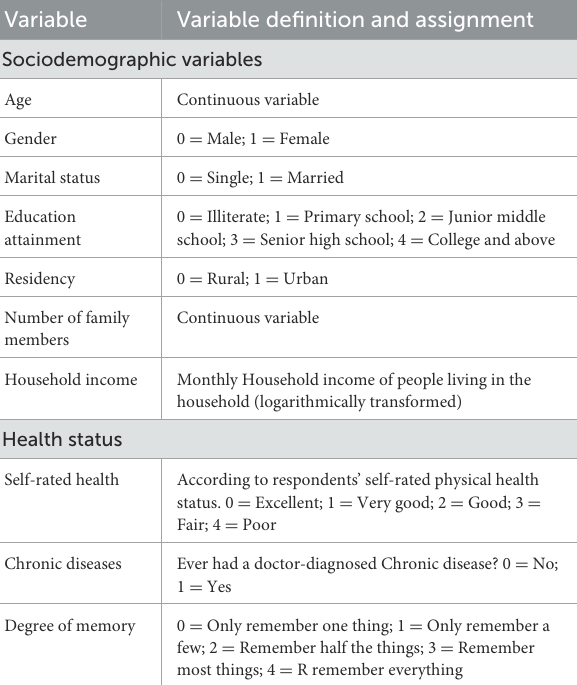
TABLE 1 Definition/codes of the potential confounding variables. TABLE 2 Sample characteristics of